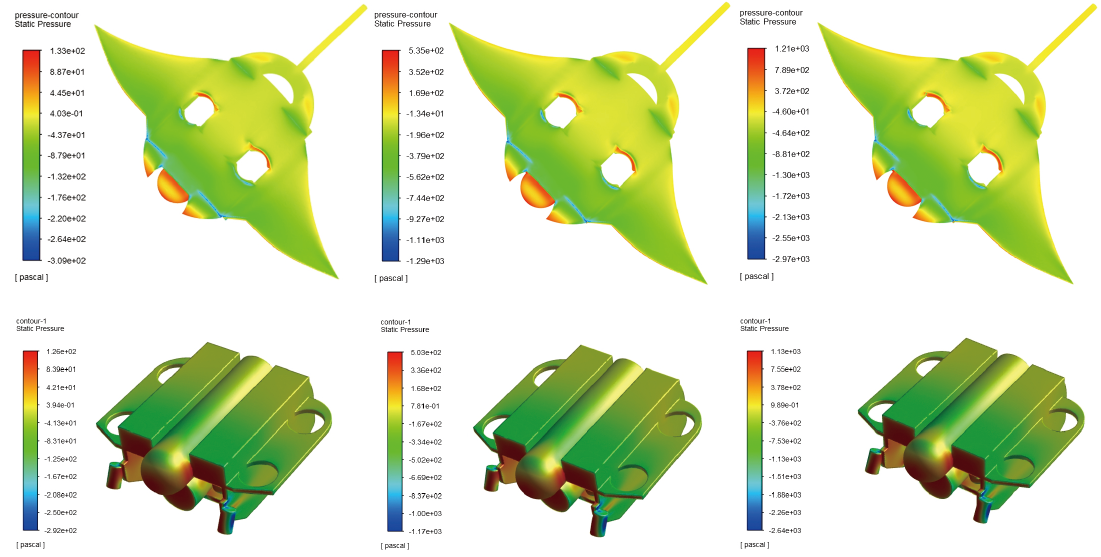
Figure 13. Contours of static pressure with different